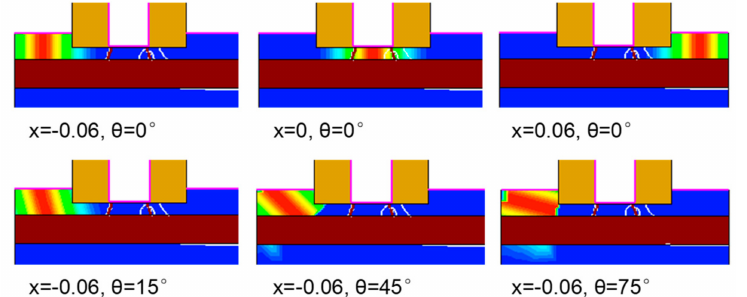
Figure 3. The charge density distribution of heavy ions at different positions and different angles of